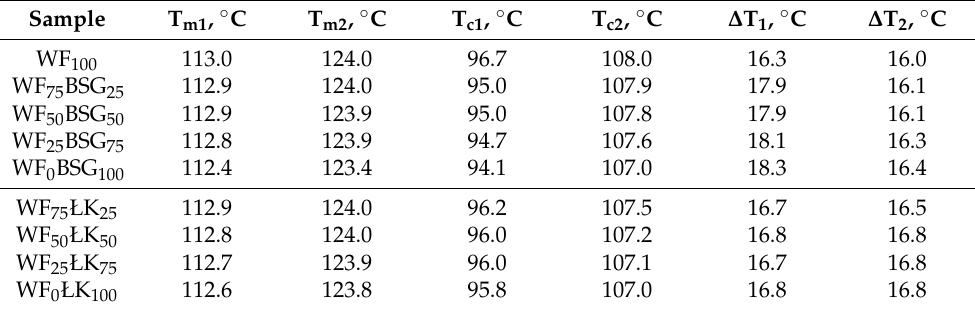
Table 4. The results of differential scanning calorimetry (DSC) analysis of prepared composites.